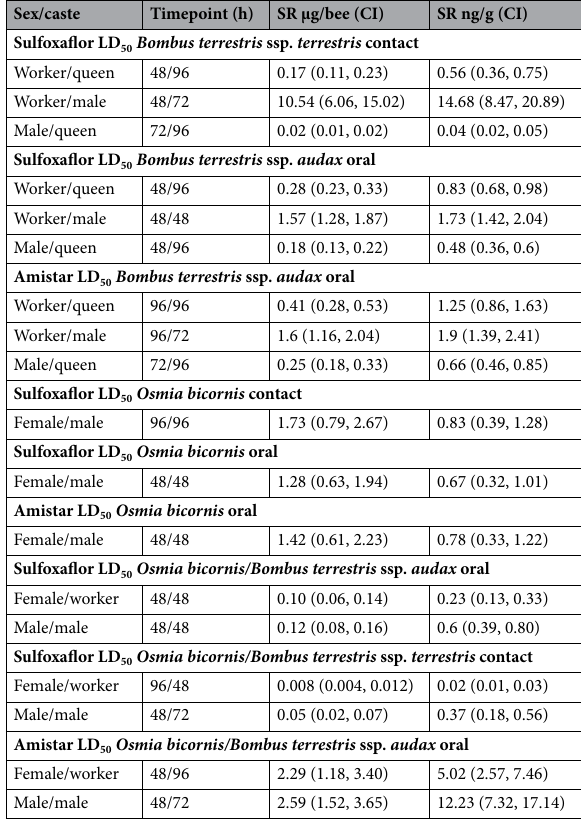
Table 2. The Sensitivity Ratio (SR) and comparison across castes and sexes of B. terrestris and O. bicornis upon acute exposure to sulfoxaflor (oral and contact) and Amistar (oral). SRs and related 95% confidence intervals were calculated using data reported in Fig. 1. Timepoints correspond to the steady-state mortality (less than 10% increase across 24 h) except in the case of O. bicornis oral exposure to sulfoxaflor and